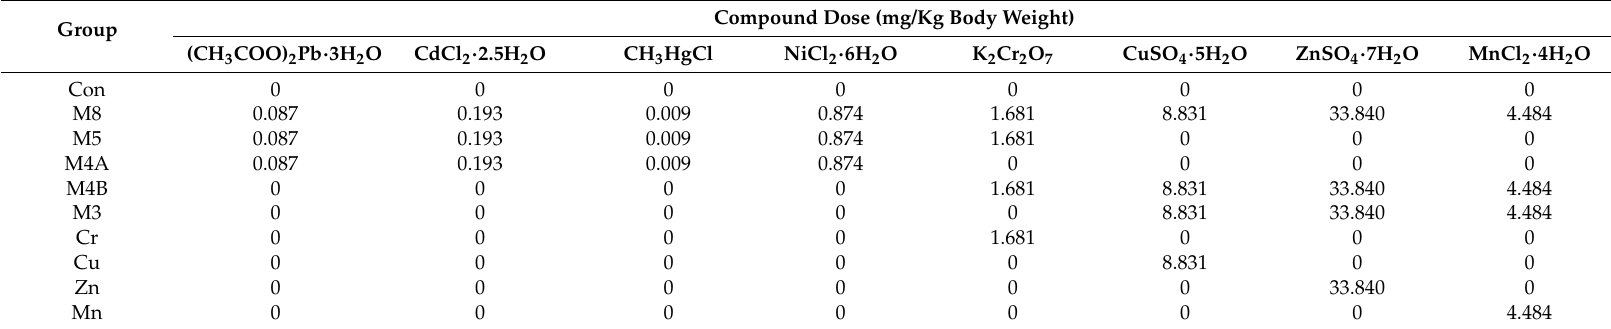
Table 1. Composition of compound dose for each